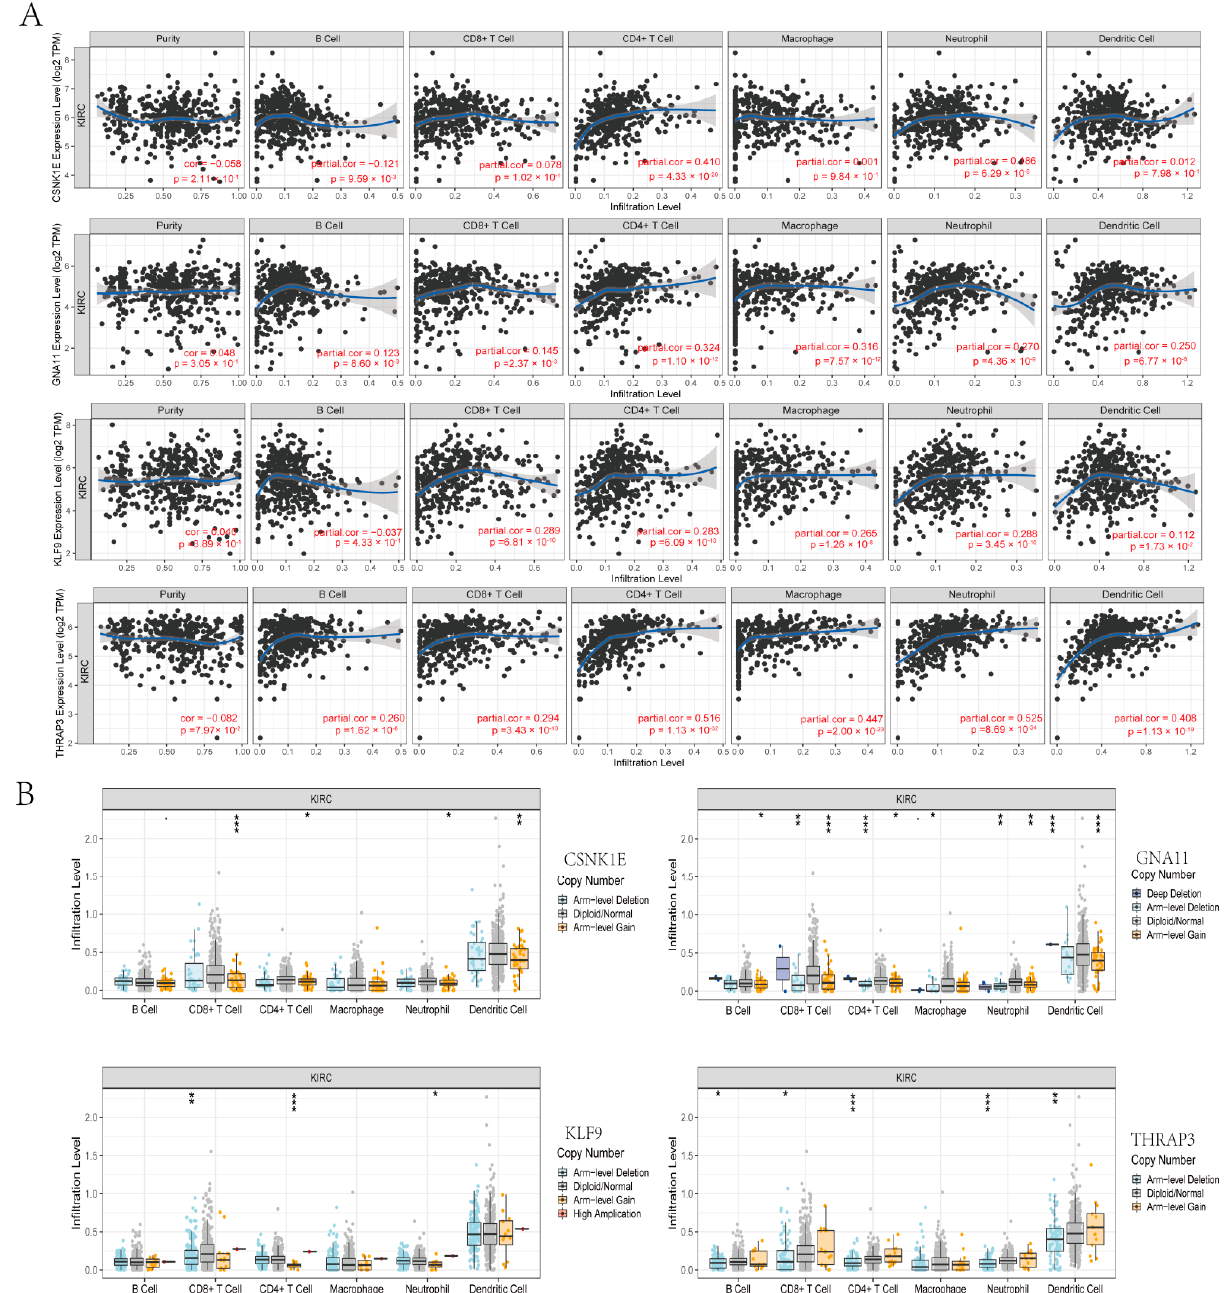
Figure 8. The correlation analyses between DERGs and immune infiltration in KIRC. ( A ) The correlation between the mRNA levels of CSNK1E/GNA11/KLF9/THRAP3 and KIRC immune infiltration; ( B ) the associations of DERGs expression alteration with immune cell infiltration.